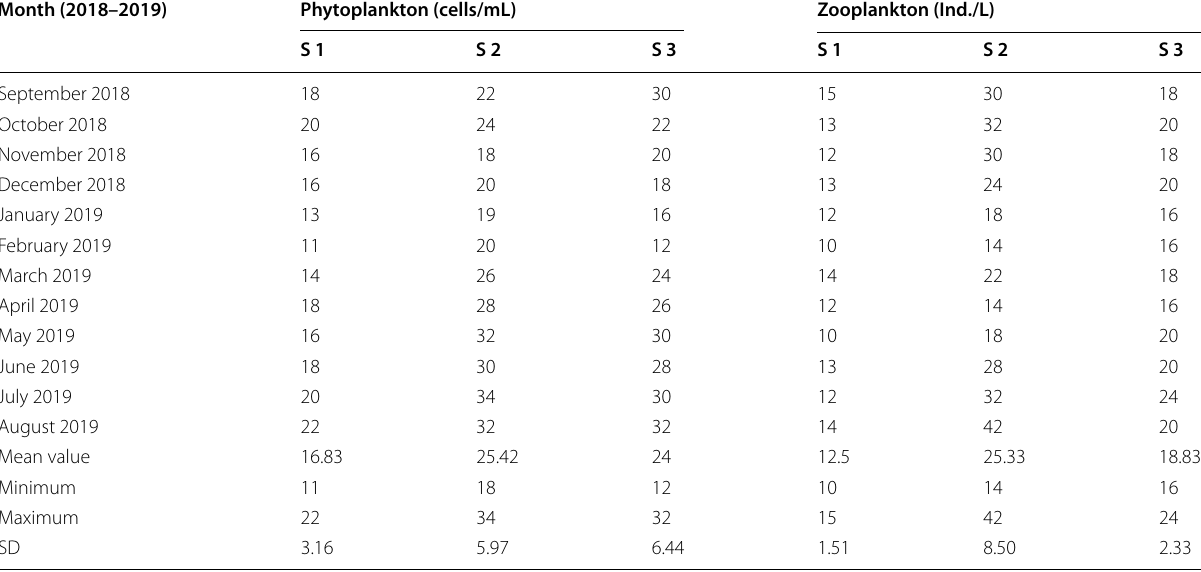
Table 9 Phytoplankton volumes (cells/ml) and zooplankton volumes (Ind./l) recorded during the period of